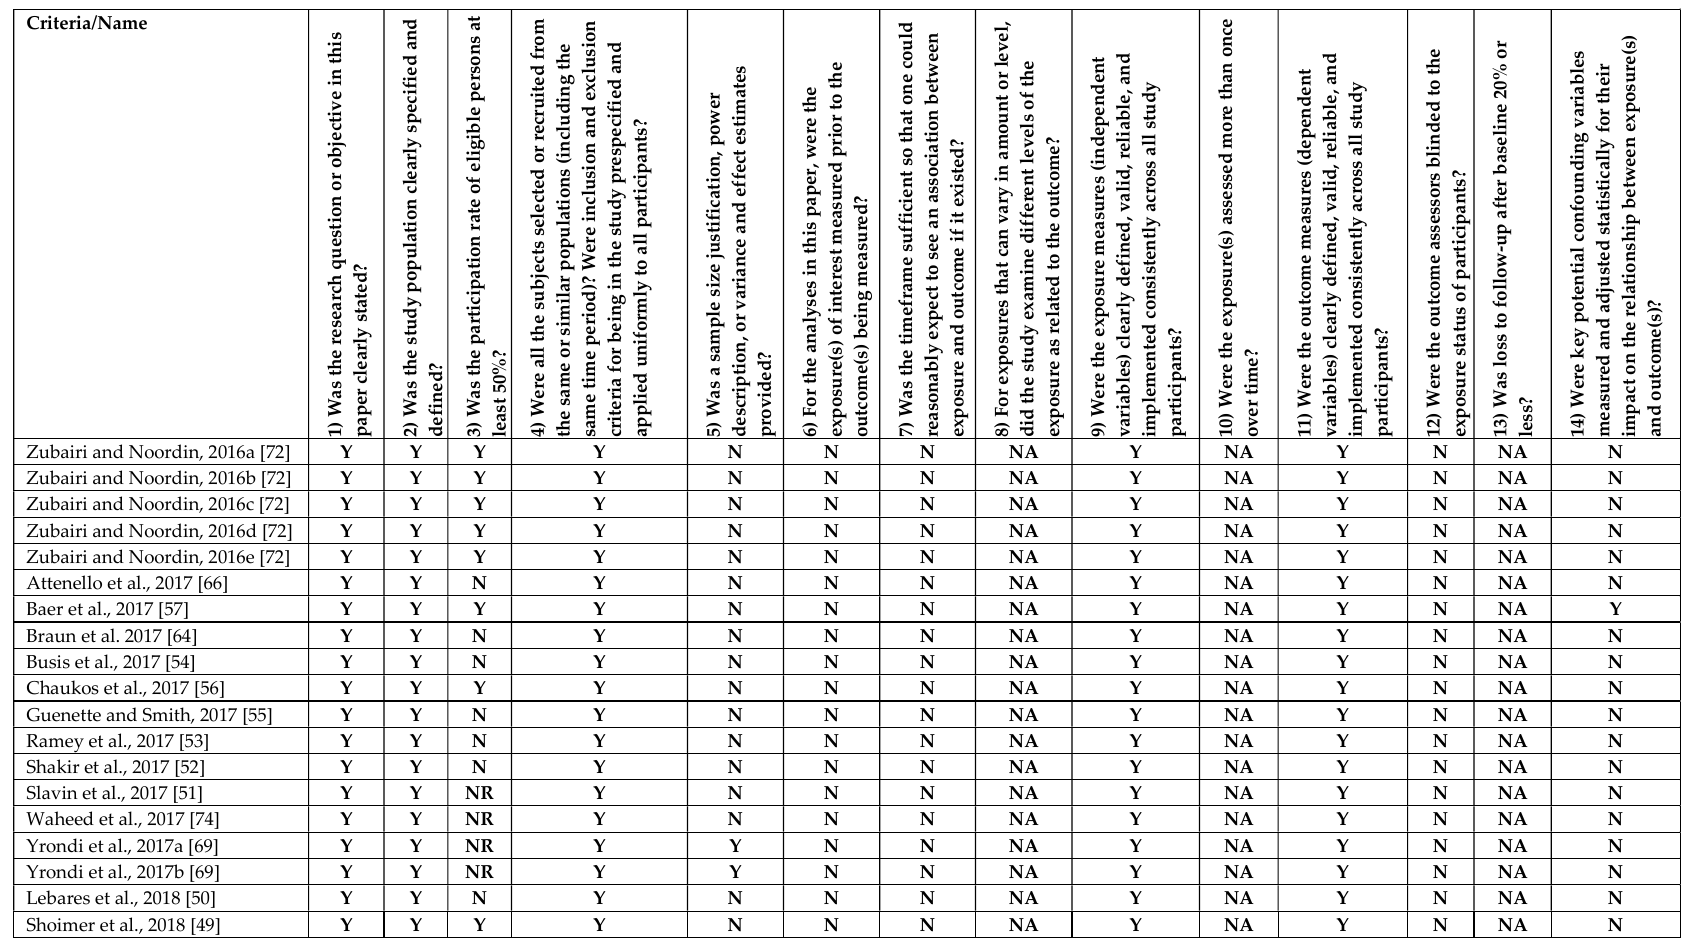
Figure A1. Summary of quality assessment of included studies. Y: Yes; N: No; NA: not applicable; NR: not reported.